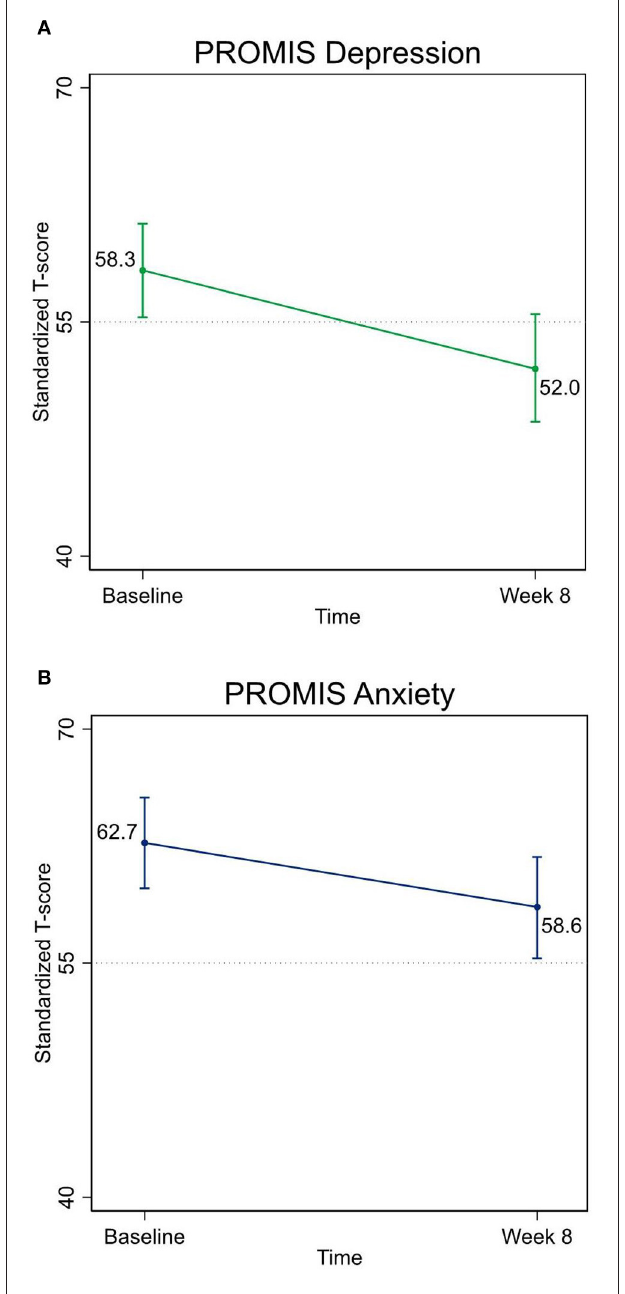
FIGURE 2 | (A) Pre-/post-reduction in depression symptoms. (B) Pre-/post-reduction in anxiety symptoms. PROMIS Depression, Patient-Reported Outcomes Measurement Information System—Depression Short Form 8a; PROMIS Anxiety, Patient-Reported Outcomes Measurement Information System—Anxiety Short Form